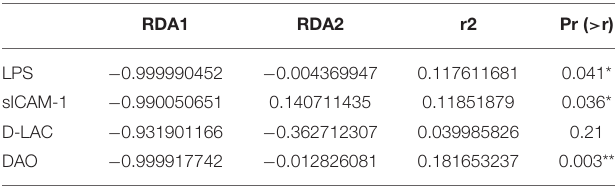
TABLE 3 | Importance of the variables in the RDA models for the microbial